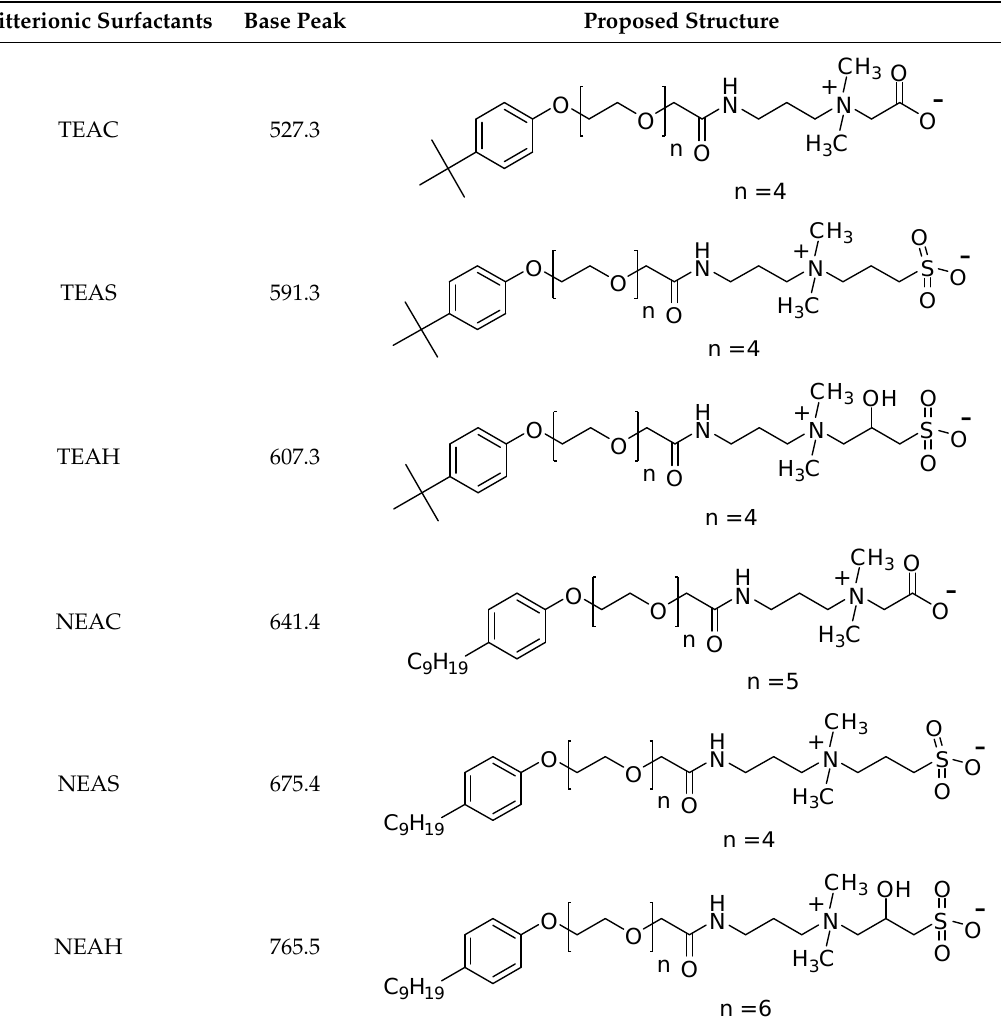
Table 4. MALDI-ToF-MS analysis of zwitterionic surfactants (TEAC, TEAS, TEAH, NEAS, NEAC, and